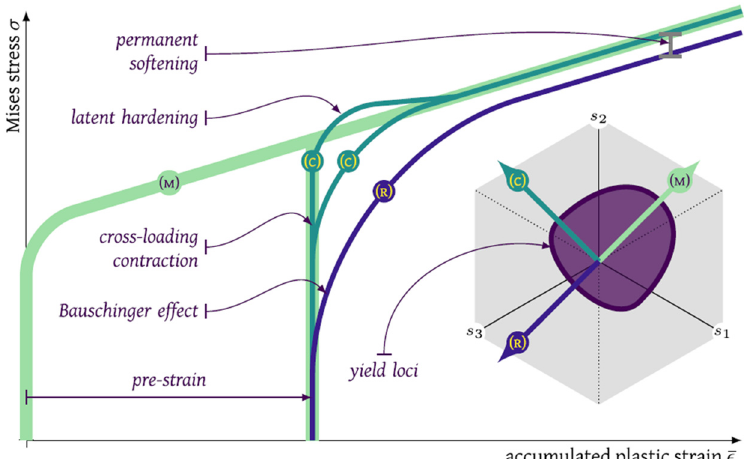
Figure 10. Graphical summary of the non-linear strain path effects: (M) monotonic represents no strain path change; (C) cross-loading is an orthogonal change of strain path in the deviatoric stress space; (R) reverse loading is an inversion of the reference direction. Reprinted from Ref. [166] with permission. Copyright 2022, Elsevier.